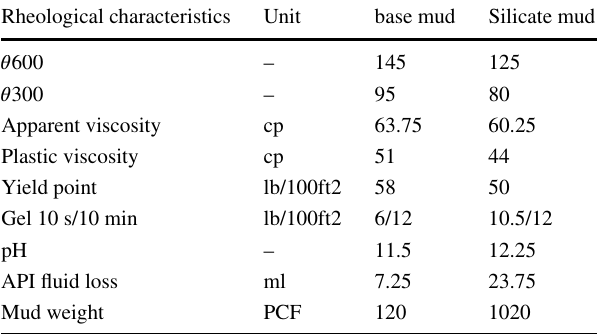
Table 3 Rheological